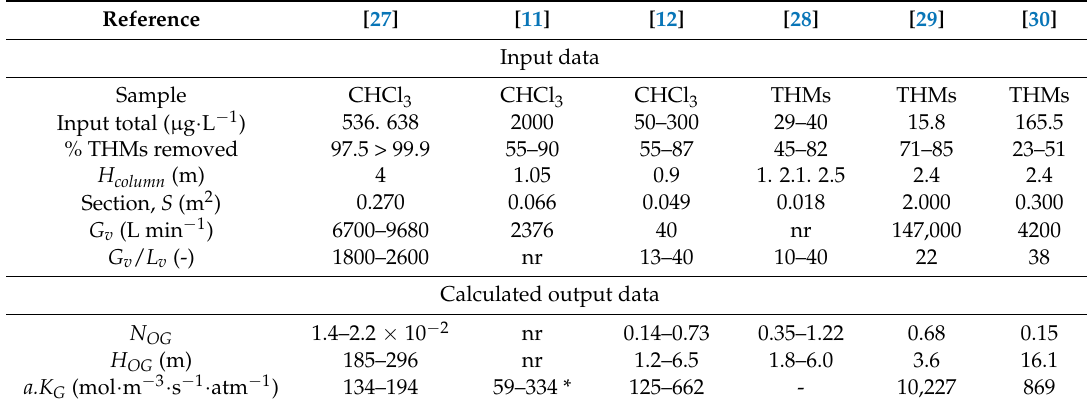
Table 5. Parameters for stripping columns from